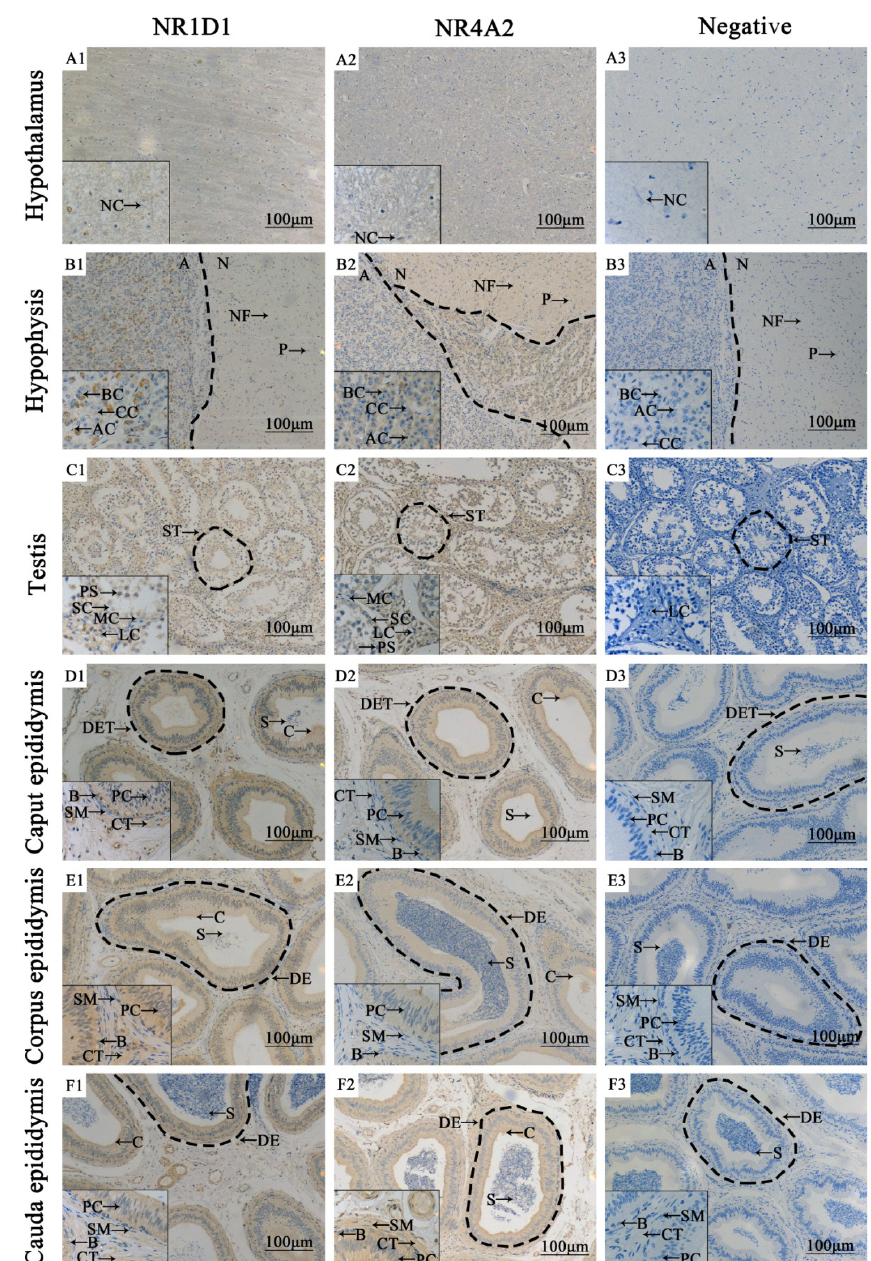
Figure 2. Localization of NR1D1 and NR4A2 proteins in adult male yak (4 years old) HPG tissues. ( A1 – F1 ), Localization of NR1D1 protein in adult male yak HPG tissues. ( A2 – F2 ), Localization of NR4A2 protein in adult male yak HPG tissues. ( A3 – F3 ), The negative control of adult male yak HPG tissues. NC, neurogliocyte (100 × ). The box in the lower left corner is a partial enlarged view (400 × ). A, adenohypophysis; N, neurohypophysis; P, pituicyte; AC, acidophilic cells; BC, basophilic cells; CC, chromophobe cells; NF, nerve fibers; ST, seminiferous tubule; MC, myoid cells; LC, interstitial cells; SC, spermatogonium; PS, primary spermatocyte; S, spermatozoon; DET, ductuli efferentes testis; B, basal cells; PC, principal cells; SM, smooth muscle cells; CT, connective tissue; DE, ductus epididymidis.